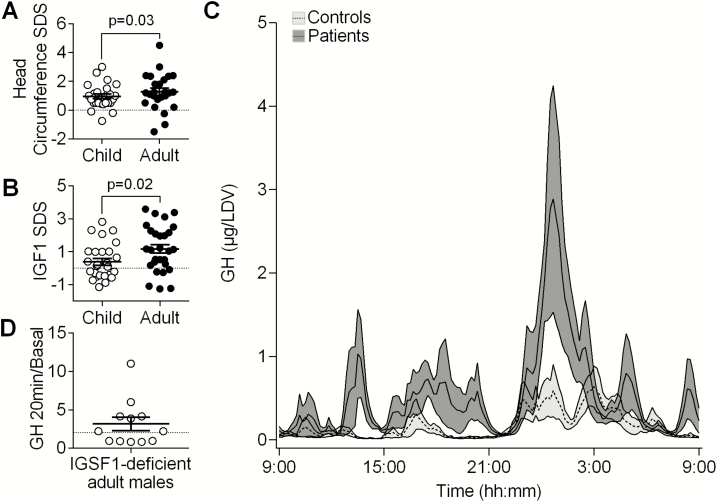
Measurements in IGSF1-deficient patients. (A) Head circumference SDS for 26 IGSF1-deficient children aged 1 to 16 years and 25 male adult patients aged 19 to 89.5 years. (B) IGF1 SDS in children aged 0.2 to 17.6 years (n = 27) and adults aged 18.1 to 88.1 years (n = 28). (C) 24-hour GH secretion profiles in micrograms per liter distribution volume for adult patients (n = 7, dark gray) and controls (n = 14, light gray), mean and SEM. (D) GH in micrograms per liter at 20 minutes/basal GH during a 200 µg TRH stimulation test in 12 adult patients, with values above the dotted line representing a paradoxical increase (peak to basal GH ratio > 2 µg/L). (A and B) Bars denote mean and SEM, and broken lines denote the 0 SD reference value. P values were calculated using a Mann-Whitney U test. Abbreviations: SDS, standard deviation score; TRH, thyrotropin-releasing hormone.